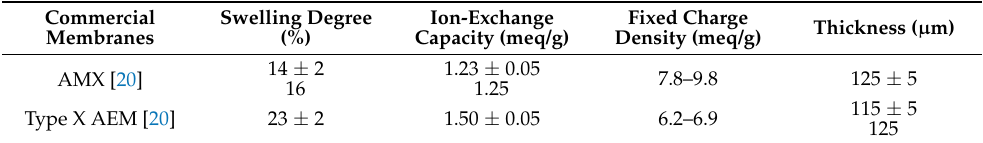
Table 3. Characteristics of the commercial membranes used as reference in this